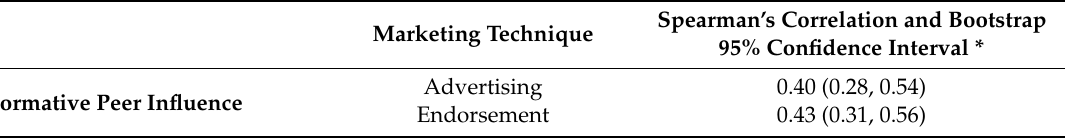
Table 6. Correlations between normative peer influence and marketing